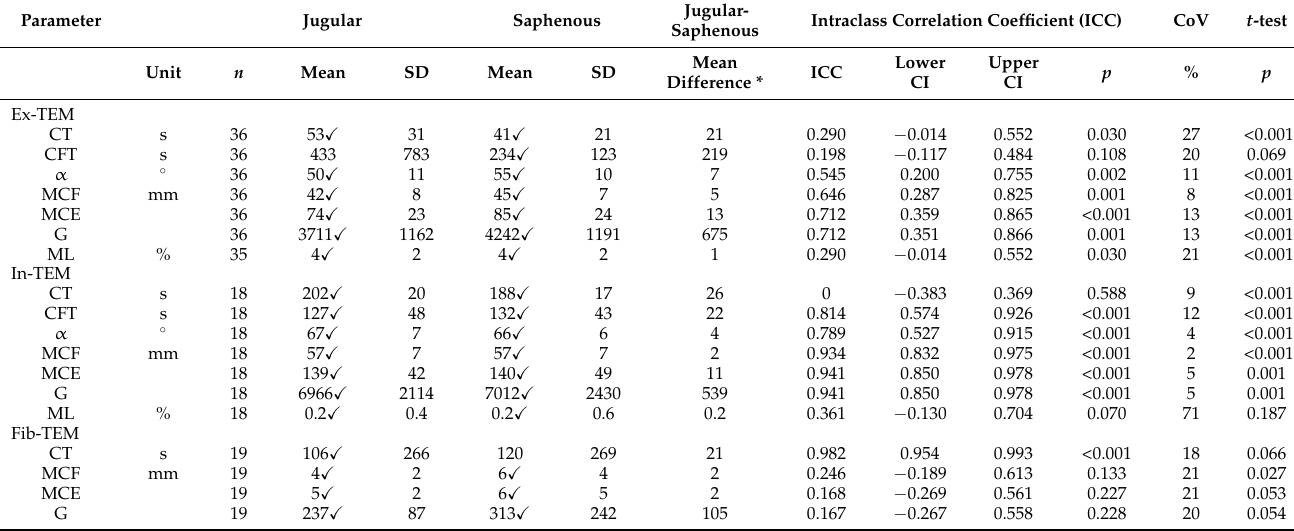
Table 1. Comparison of jugular and venous ROTEM parameters in simultaneously measured blood